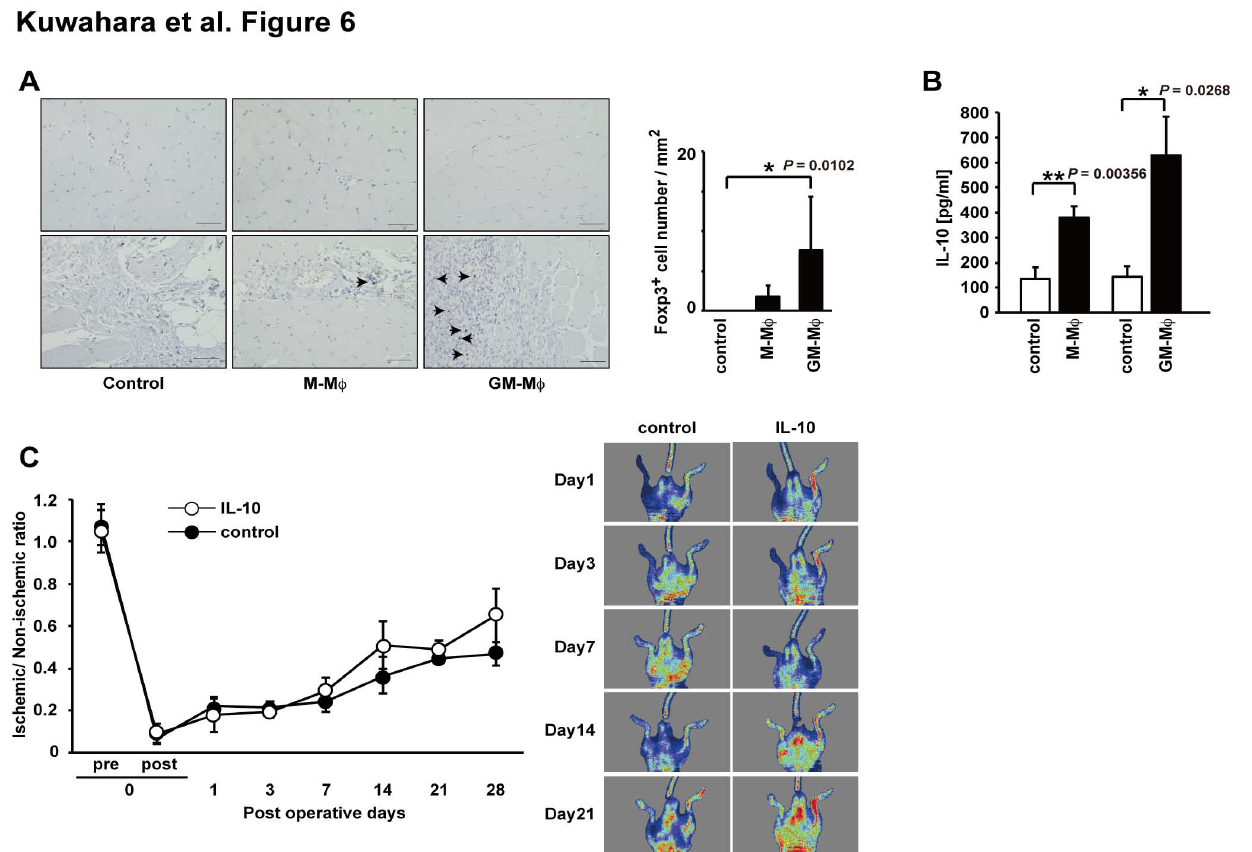
Figure 6. Foxp3 expression in M-Mø or GM-Mø treated ischemic hind limbs and the recovery of blood flow in ischemic limbs treated with IL-10. (A) Photomicrographs show representative DAB staining for Foxp3 (scale bar=50 m m). The number of Foxp3 positive cells was counted in five random images for each mouse. The thigh muscle of each group was isolated 7 days after the induction of ischemia. (B) IL-10 levels in thigh muscle after limb ischemia at 7 days after intramuscular injection of indicated cells (data are expressed as mean 6 SEM, n=3 group, *** P , 0.001, ** P , 0.01, * P , 0.05). (C) Recovery of blood flow in ischemic limbs treated IL-10. Representative laser doppler perfusion images were taken at indicated intervals for the PBS control groups and IL-10 treated groups. Data are expressed as mean 6 SEM,